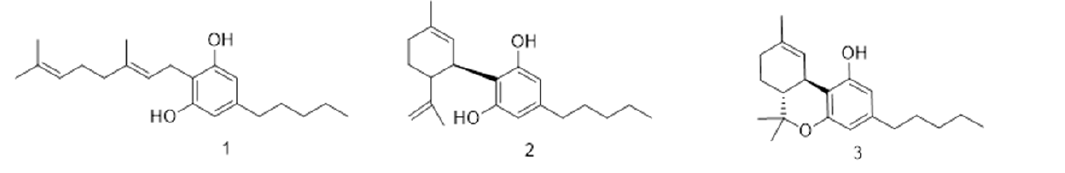
Figure 1. Structure of Cannabigerol (1), Cannabidiol (2), and Δ 9 -tetrahydrocannabinol (3).